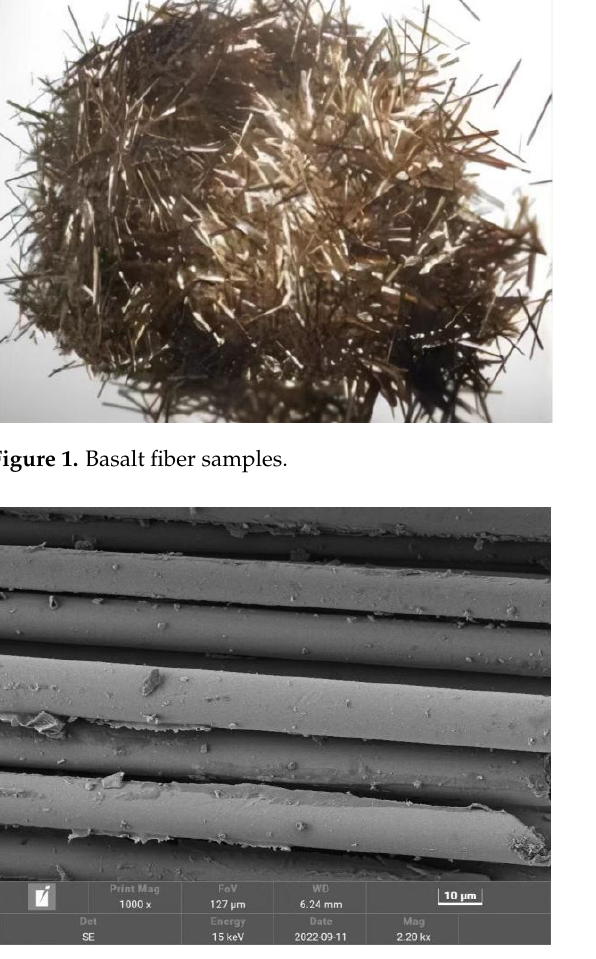
Figure 2. Characterization of basalt fiber morphology.